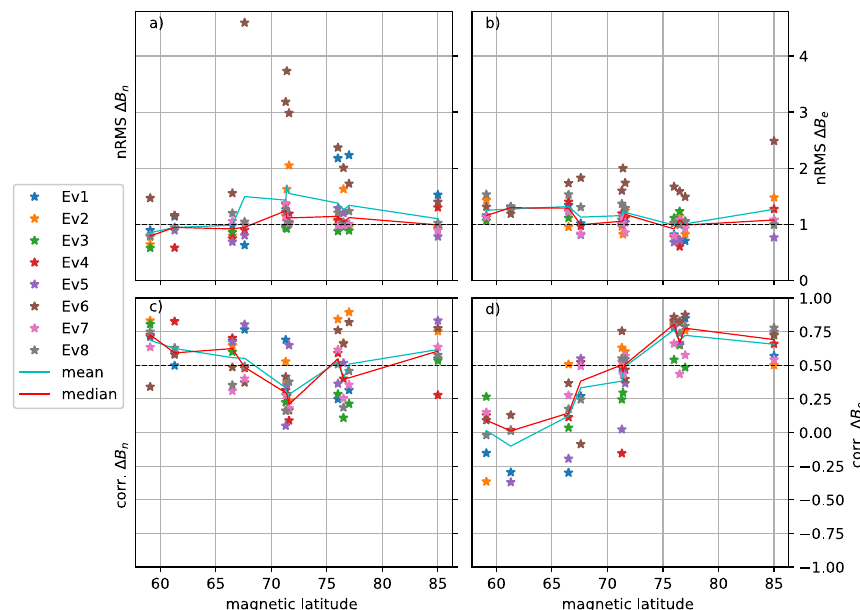
Fig. 2. Normalised root mean square error (nRMS) in panels a and b and cross correlation coef fi cient (corr.) between the ground magnetometer observations and the model D B n and D B e in panels c and d for all events and magnetometer stations. The cyan and red lines show the mean and median metrics value at each magnetometer